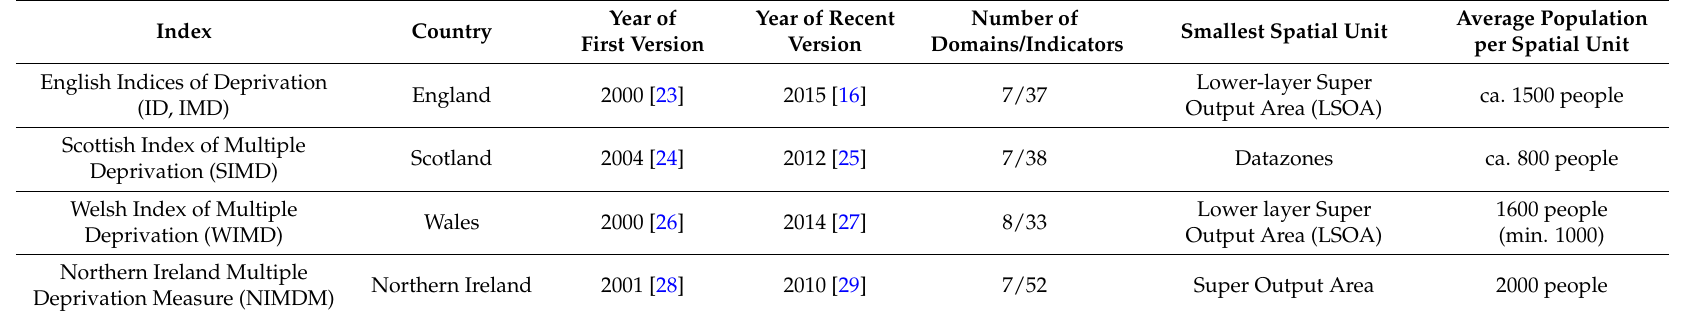
Table 1. Indices of Multiple Deprivation in the UK (given information is based on the most recent